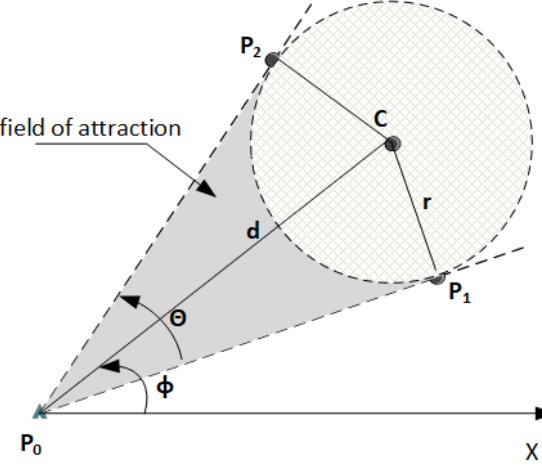
Figure 2. Sensing power and its field of